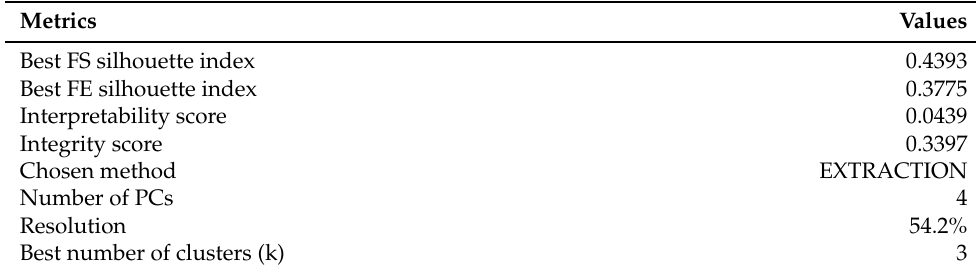
Table 9. Algorithm results using interpretability-oriented = 0.1, integrity-oriented = 0.9 and target- resolution =